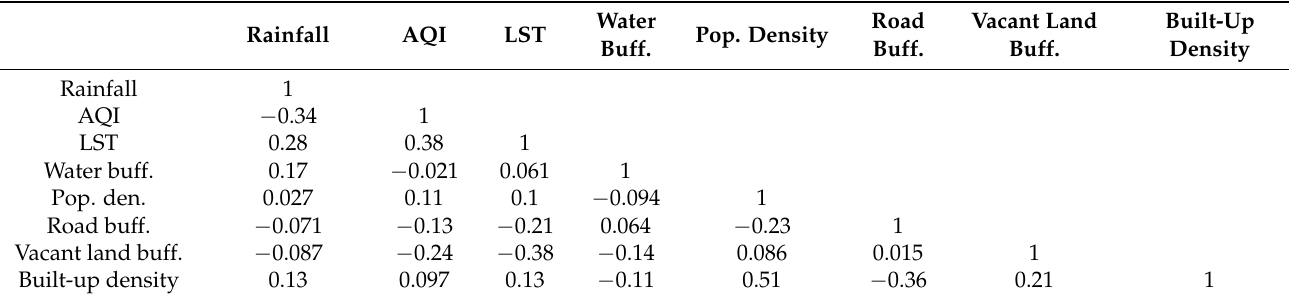
Table 4. Pearson’s correlation coefficient pairs of